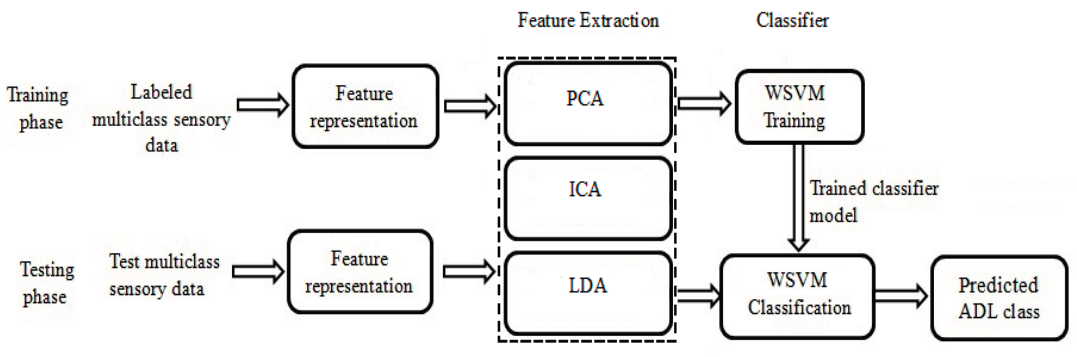
Figure 1. Scheme of the proposed strategy based activity recognition